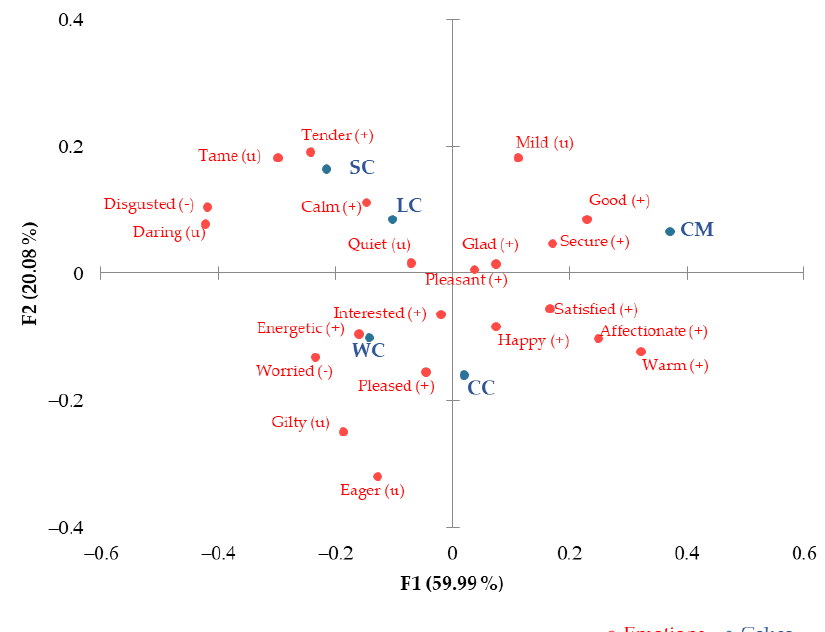
Figure 2. Correspondence analysis of the significant emotional responses obtained with CATA EsSense Profile ® . Note: (+): positive emotion; ( − ): negative emotion; (u): neutral emotion; WC: Walnut cake; LC: Leonor cake; SC: Saffron cake; CC: Coulan cake; CM: Chocomuffin.